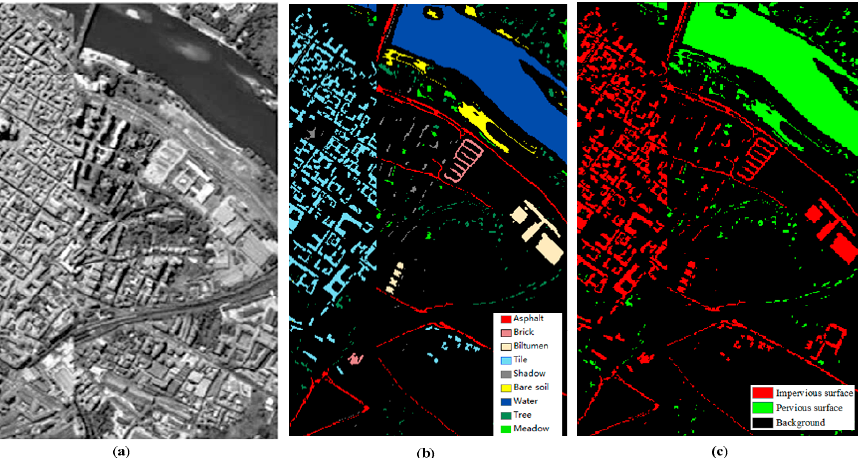
Figure 2. The city center scene of the Pavia: ( a ) single band image; ( b ) reference of ground-truth image; ( c ) reference of impervious surface image.